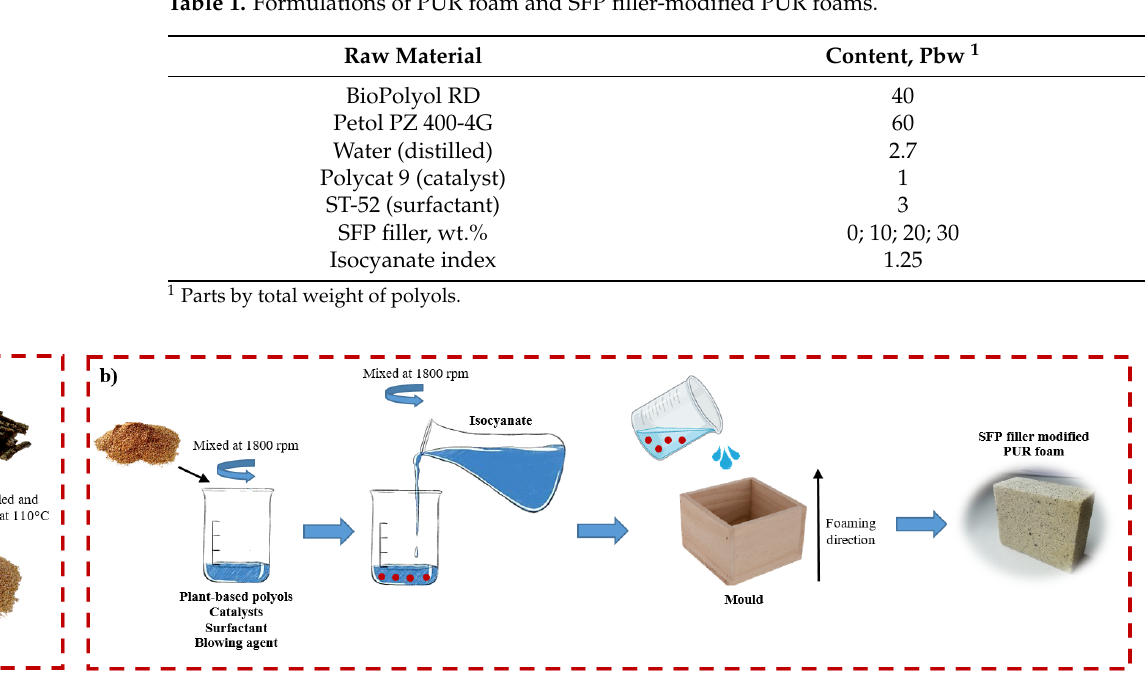
Table 1. Formulations of PUR foam and SFP filler-modified PUR foams.